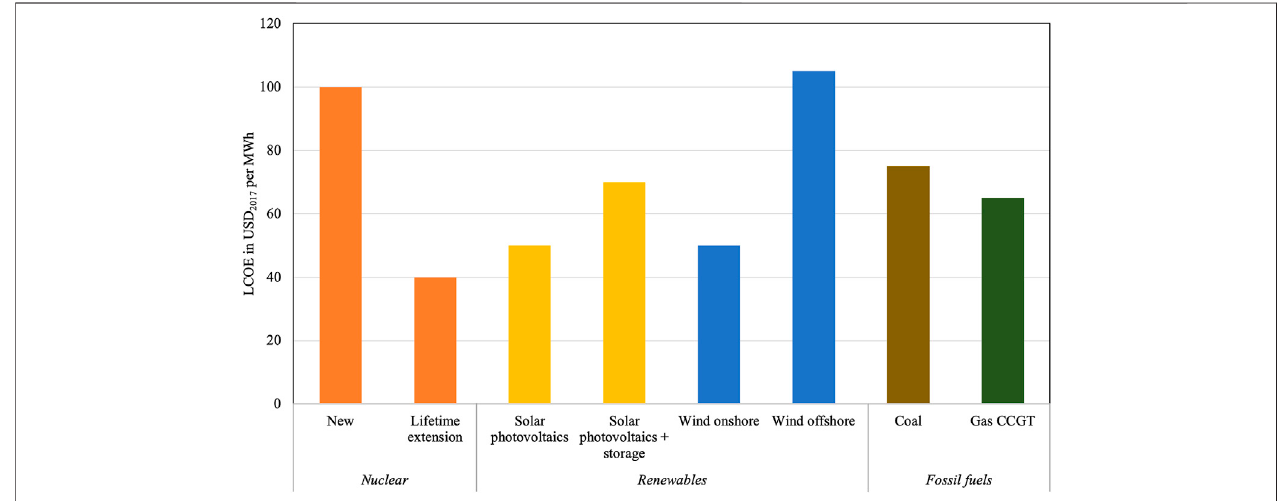
FIGURE 1 | Projected US LCOE by technology in 2040 [modi fi ed from IEA (2019)]. Note for Figure 1 : LCOE (cid:1) levelized cost of electricity, average cost to build and operate a power plant over its lifetime divided by the total electricity output of the plant over the same period; it represents the break-even price of electricity generation at a power production facility. CCGT (cid:1) combined-cycle gas turbines. Estimates of nuclear lifetime extension are based on a 500 million USD investment to extend operations for 20 years. Other cost assumptions can be found in IEA (2019).